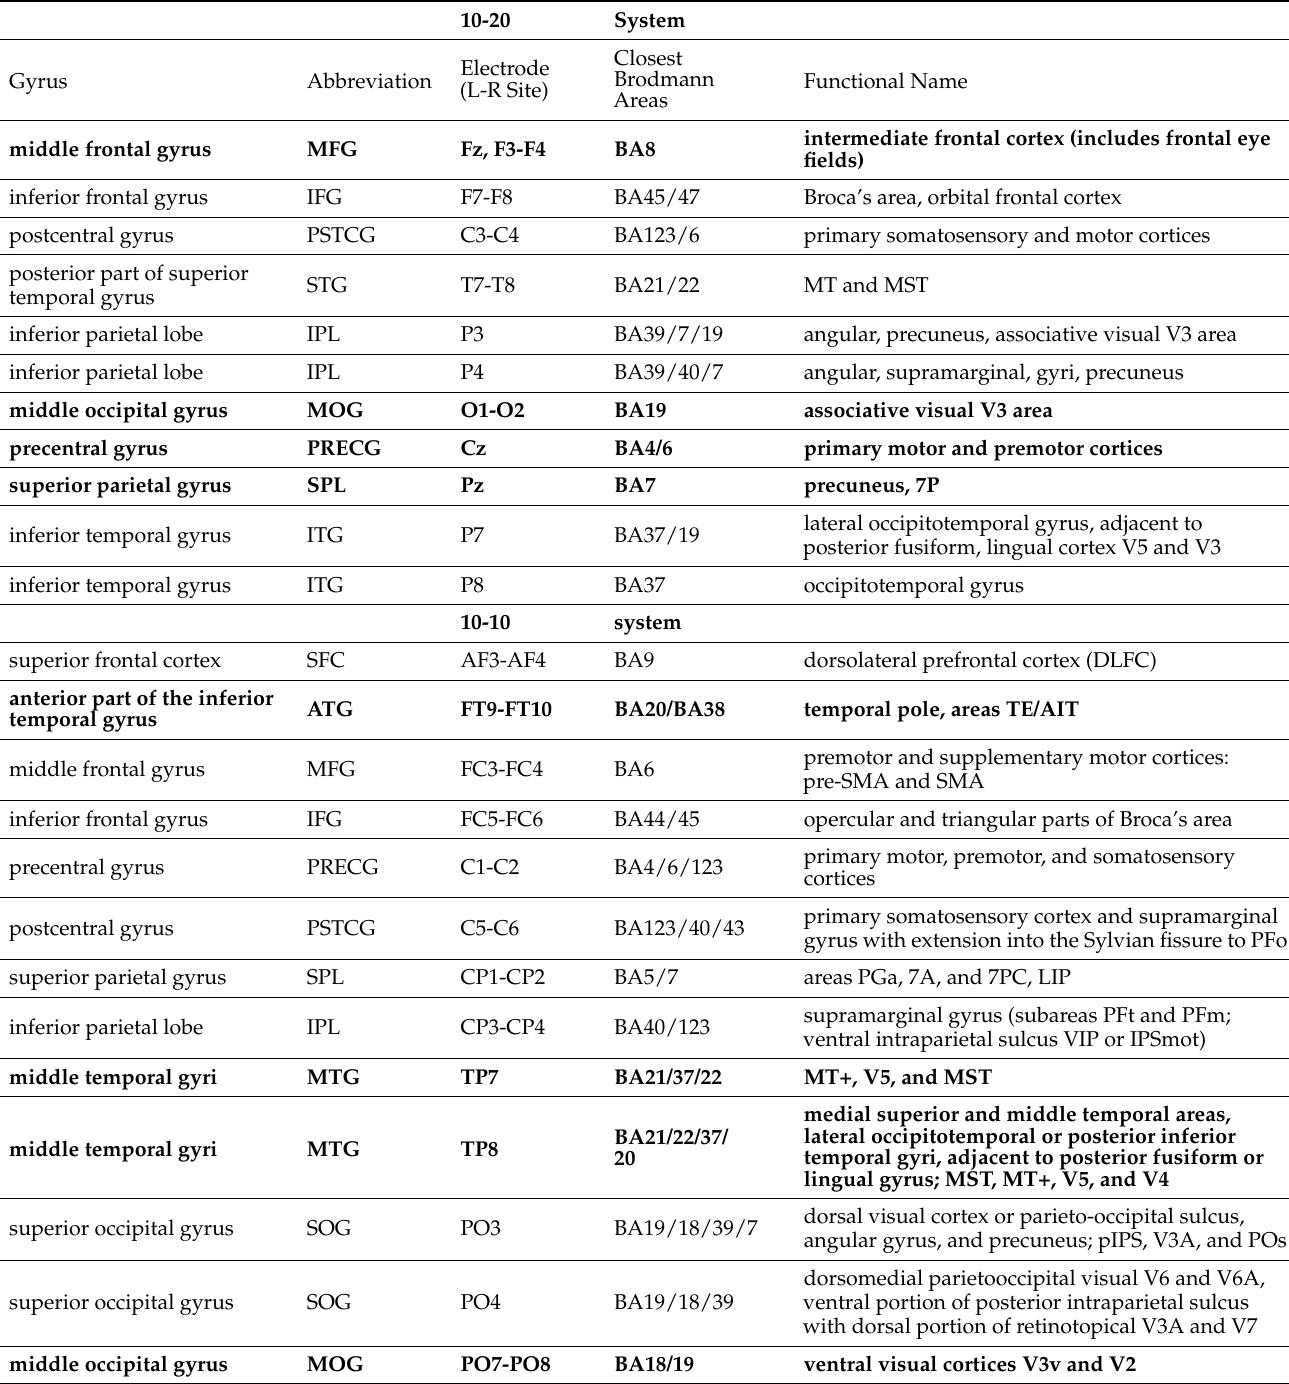
Table 3. Forty sensor locations covering adjacent brain areas. Twelve NF sensors (eight areas) are marked in